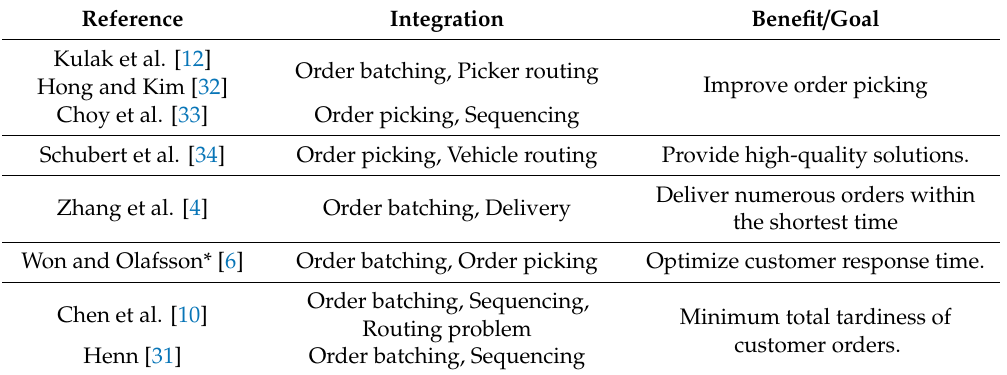
Table 2. The integrated studies in recent